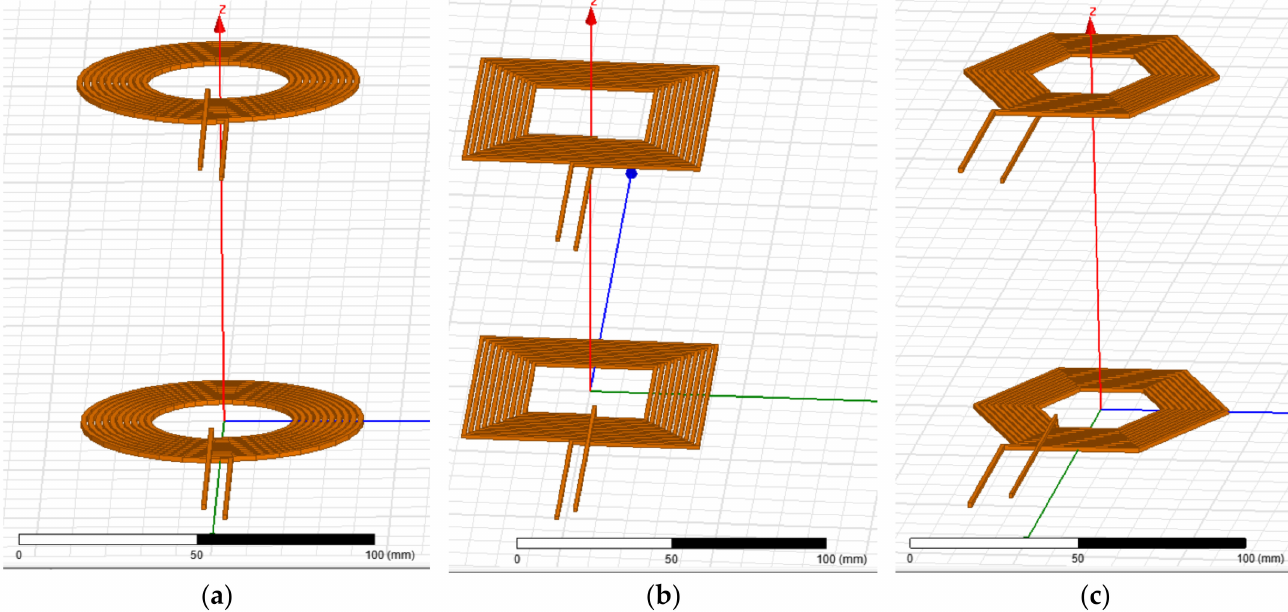
Figure 22. The three cases: ( a ) circular coreless model, ( b ) rectangular coreless model, ( c ) hexagonal coreless